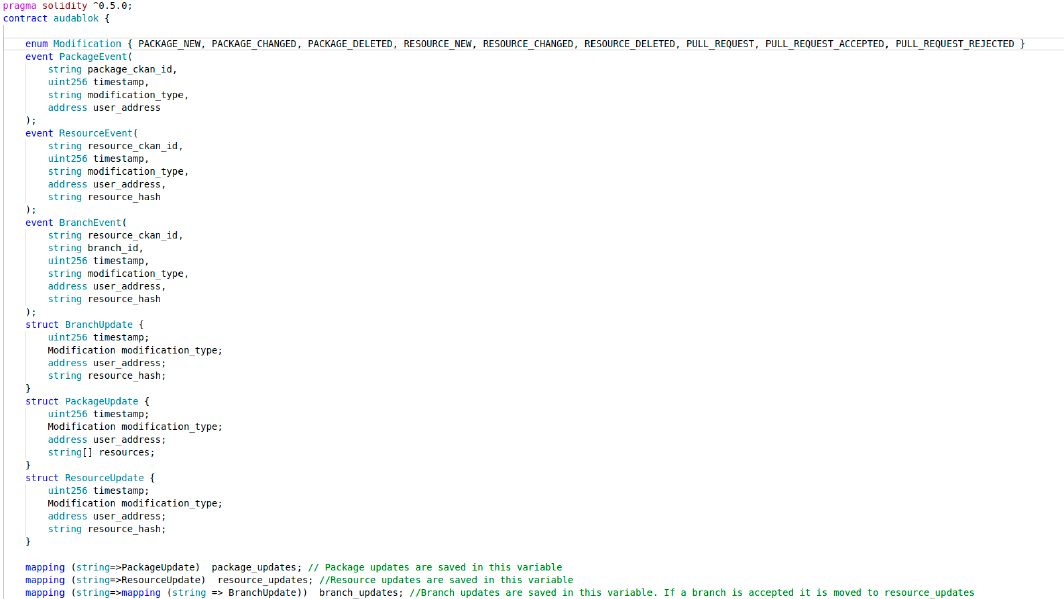
Figure 8. AUDABLOK smart